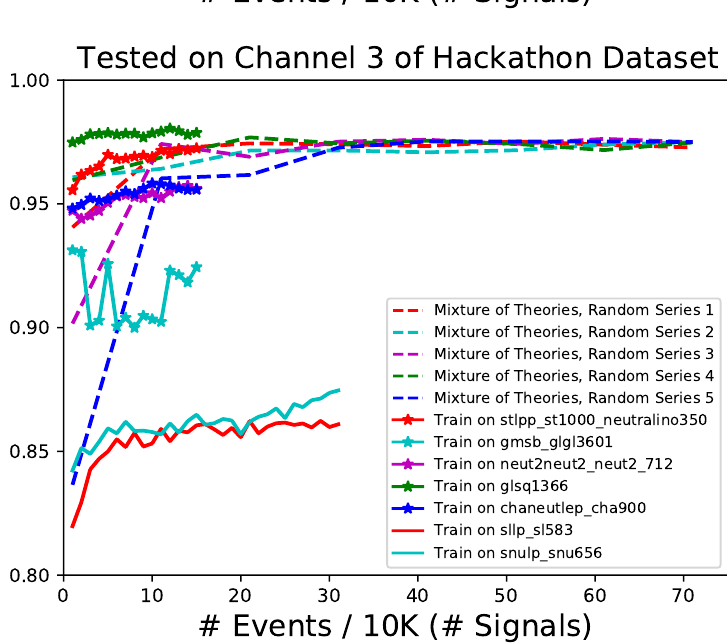
Figure 1 . The figure shows the median AUCs of the trained ML models for channels with hadronic final states, tested on signals from the hackathon data . For the dashed line, the training processes based on an increasing number of signals with a point size of 10k are repeated 5 times per channel in random rows. The steps of adding signals to the training set are (5, 10) for (channel 1, channel 3), while all channels with the ML model start with only one signal in the training set. For the star-shaped lines, we use only 1 single signal and gradually increase the number of events in steps of 10k. The solid lines are similar to the star lines trained with a single signal. However, additional events are generated to extend the